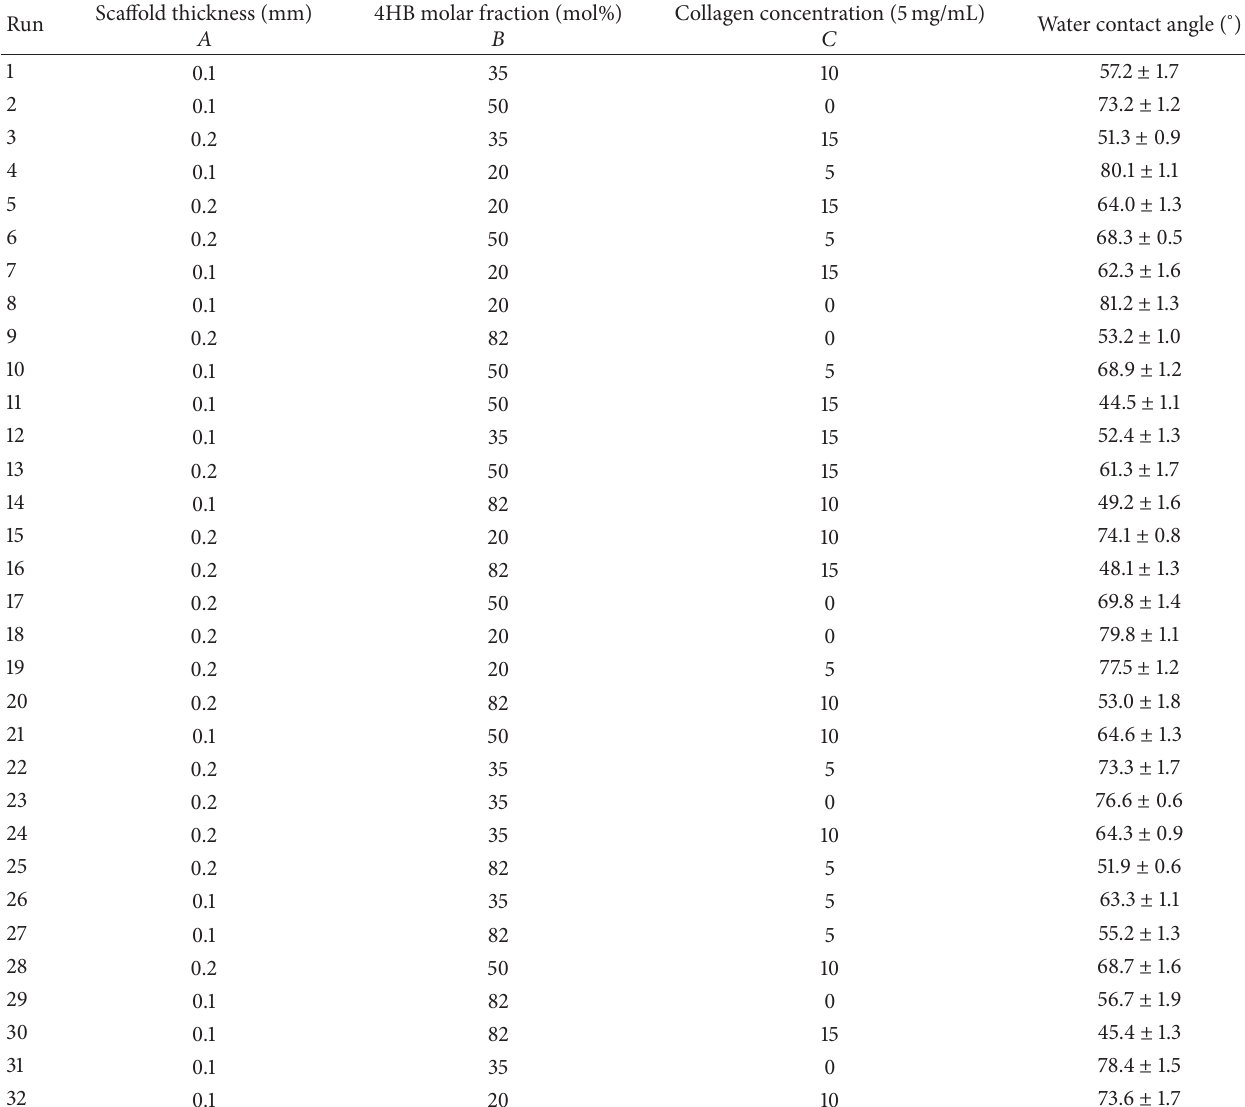
Table 4: Variables of P(3HB- co -4HB)/collagen blend scaffold fabrication and response.